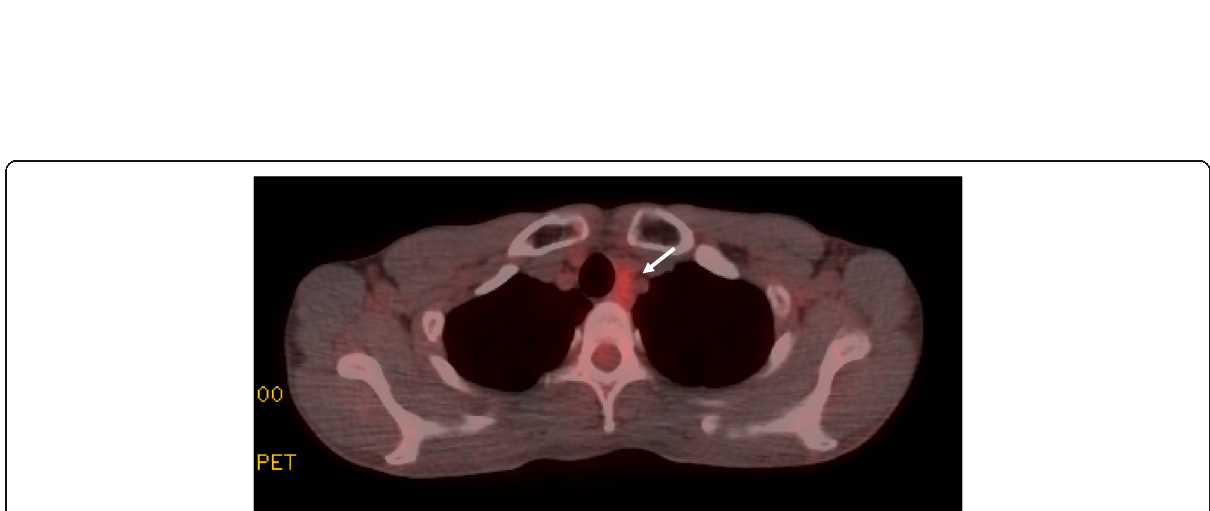
Fig. 5 Fluorine-18 fluorodeoxyglucose positron emission tomography indicated abnormal uptake (arrow) within the upper mediastinal lymph